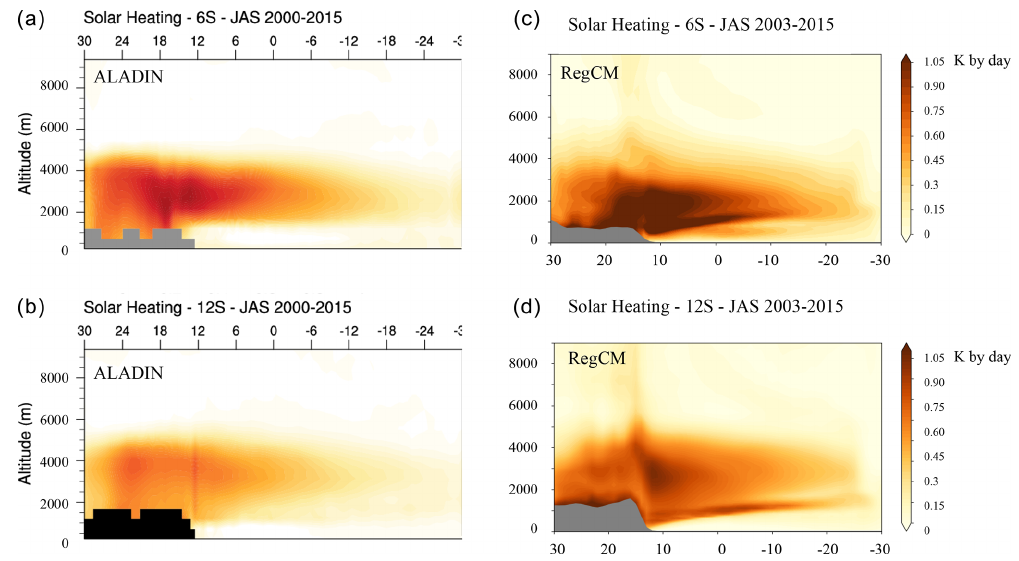
Figure 9. Seasonal-mean (JAS) changes (SMK minus CTL simulations) in the vertical profiles of SW heating rates (K by day) due to BBAs at two latitudes (6 and 12 ◦ S), for the ALADIN ( a, b , period 2000–2015) and RegCM ( c, d , period 2003–2015) models.